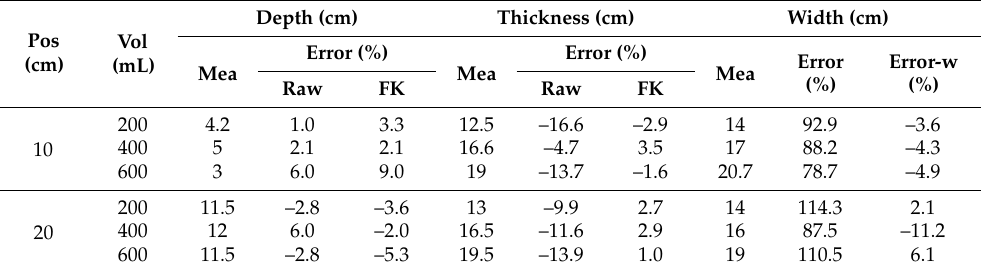
Table 6. GPR detection error for the depth, thickness, and width of the bubbler irrigation